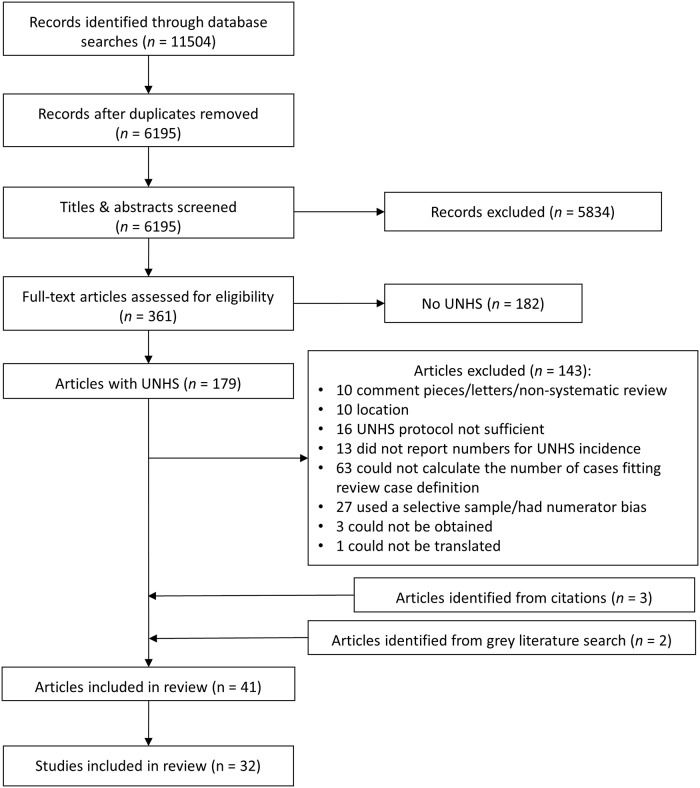
PRISMA flow diagram.